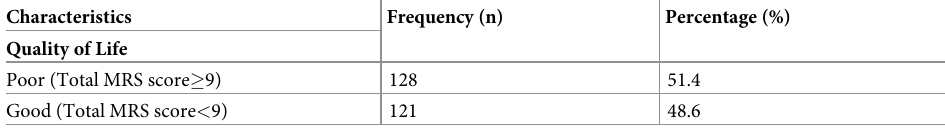
Table 3. Quality of life among menopausal women using the Menopausal Rating Scale (MRS).